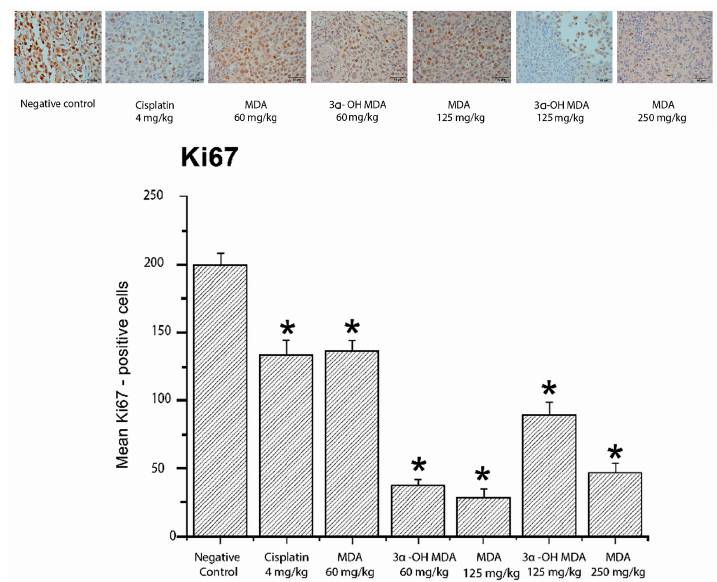
Figure 5. MDA and 3 α -OH MDA inhibit the expression of proliferation marker Ki67. Quantitative analysis of Ki67-positive cells was performed by using Image-Pro Plus 7.0 software (Media Cybernetics Inc., Rockville, MD, USA). The data are shown as the means ± SEM of three xenografts analyzed for each group. * p < 0.05, significant differences compared with the control.